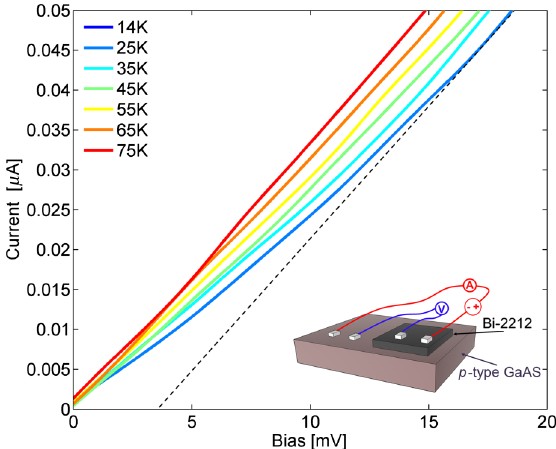
FIG. 1. Measured DC I-V characteristics for the Bi-2212/ GaAs junction at various temperatures. The dashed line indicates a linear I-V dependence coinciding with the 14-K measurement at a higher bias to indicate the excess voltage. The inset is a schematic drawing of the Bi-2212/GaAs